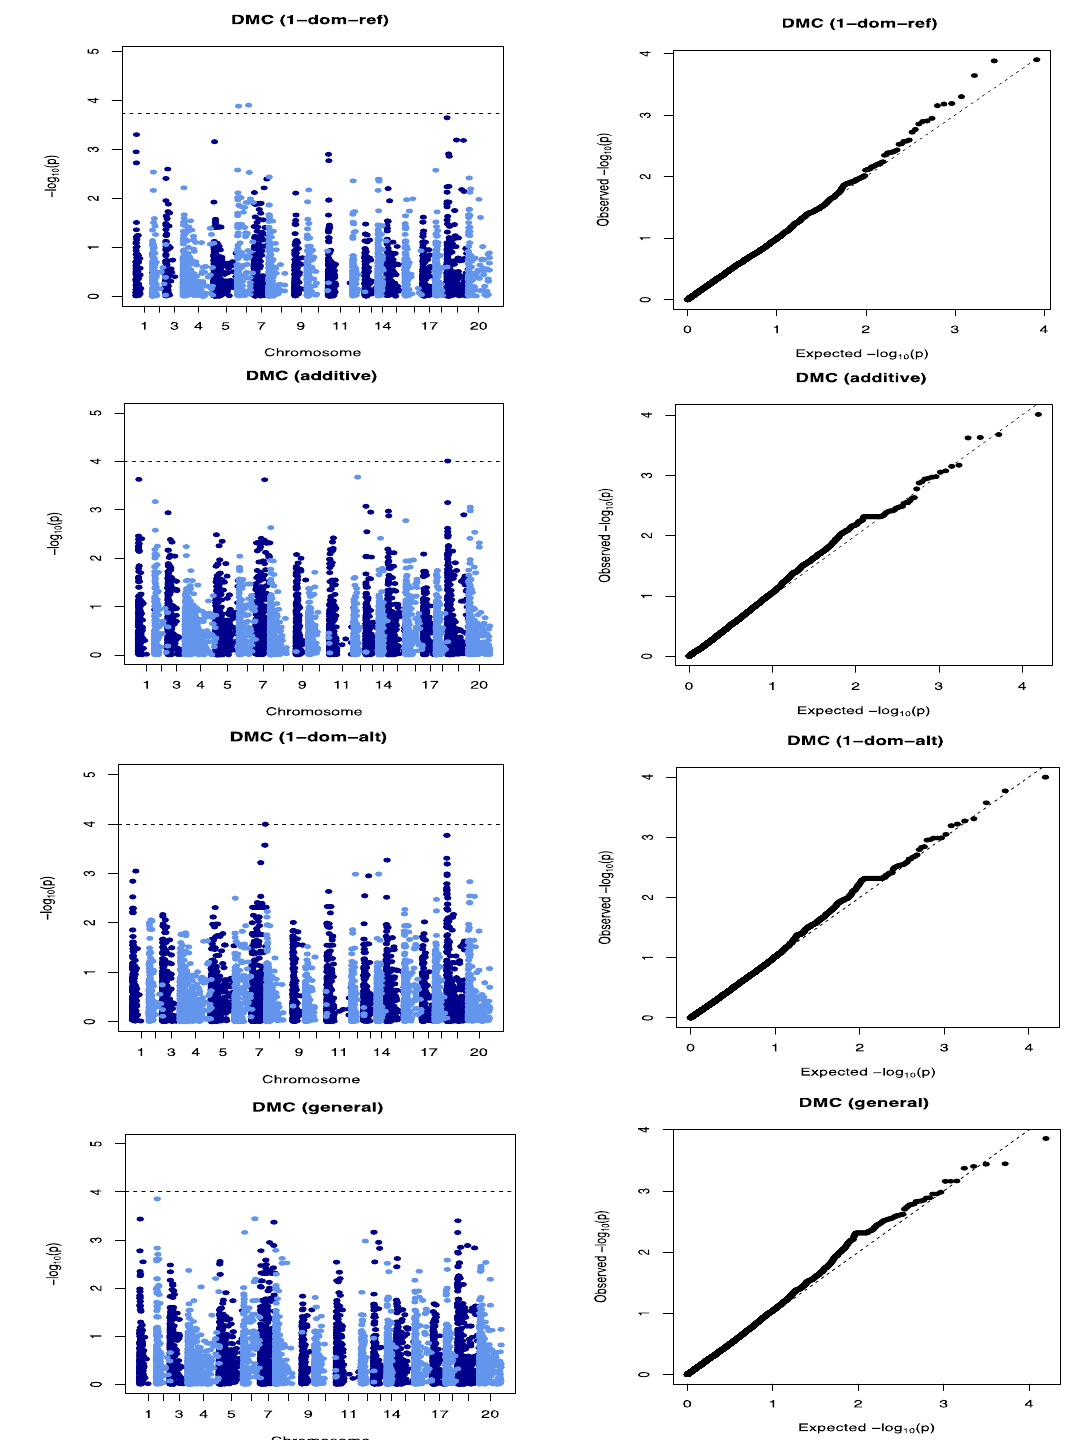
Figure 2. Genome-wide association analysis of tuber DMC. Manhattan and Quantile–Quantile plots for DMC on chromosomes 6 and 19. The dashed lines on the Manhattan plot represent the significant